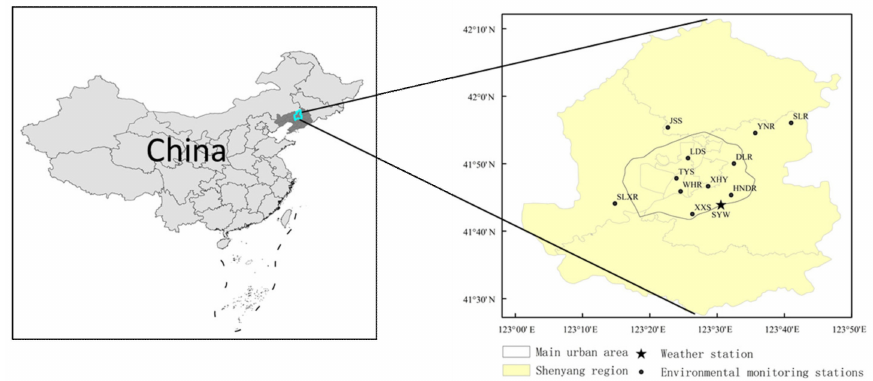
Figure 1. Locations of the 11 environmental monitoring stations and one weather station in the study